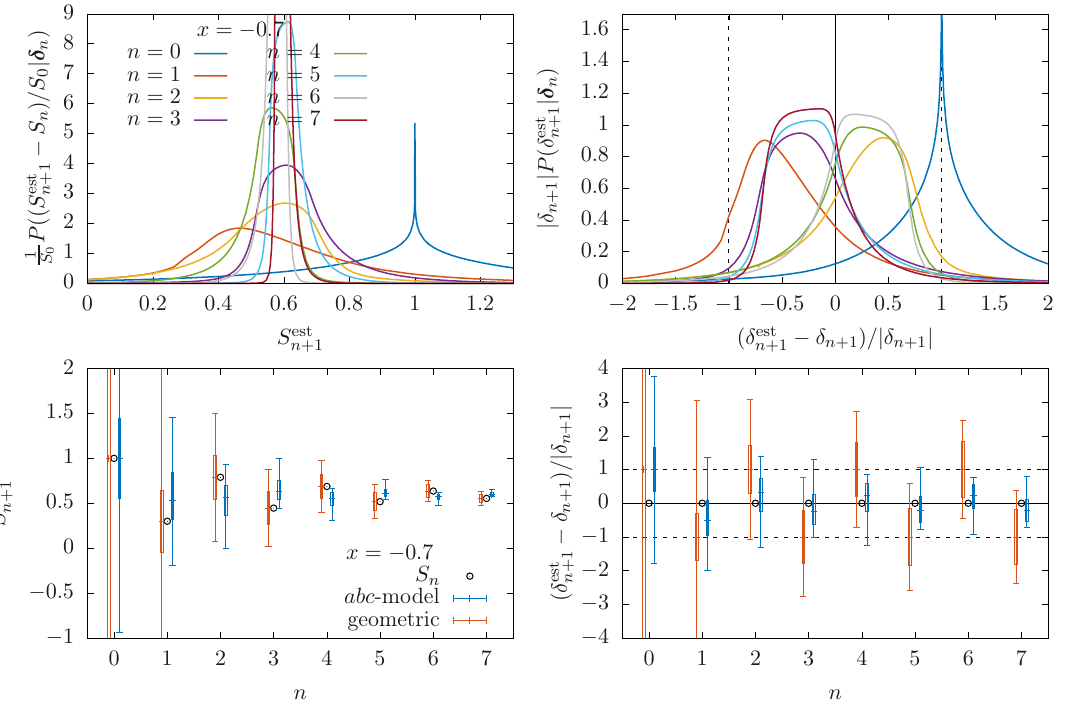
for different Figure 25 . Top left panel: the probability distribution from the abc model for S est n +1 values of n for the geometric series with x = − 0 . 7 . Top right panel: the same as the left panel, but we show the probability for the scaled deviation from the known correction ( S est − S n +1 ) / | S n +1 − S n | . n +1 Bottom left panel: the median (plus), 68% CI (errorbox) and 95% CI (errorbar) for the posterior of , computed from the abc (blue) and geometric (red) models using information on the previous S est n +1 orders. The exact values of S are shown as black circles. Bottom right panel: the same as the left n panel, but the exact S value is subtracted from S est and the difference is normalised by | S n n +1 − S n | n +1